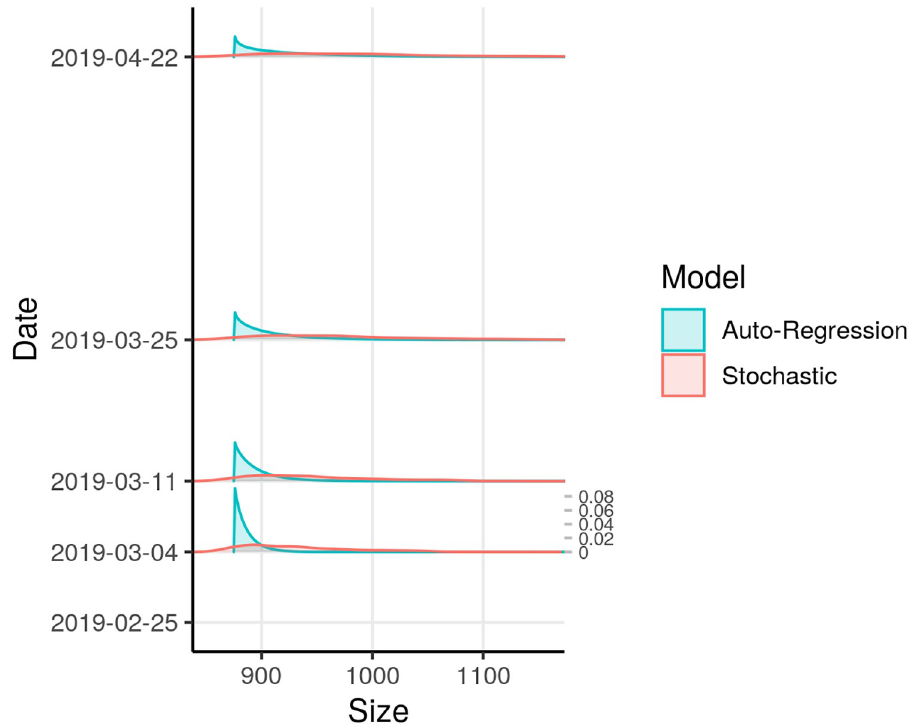
Fig 4. Short-term probabilistic projections of case counts based on reported counts as of February 25, 2019. Stochastic and auto-regression models were used. Vertical scale of probabilities, on right side of plot, applies to all